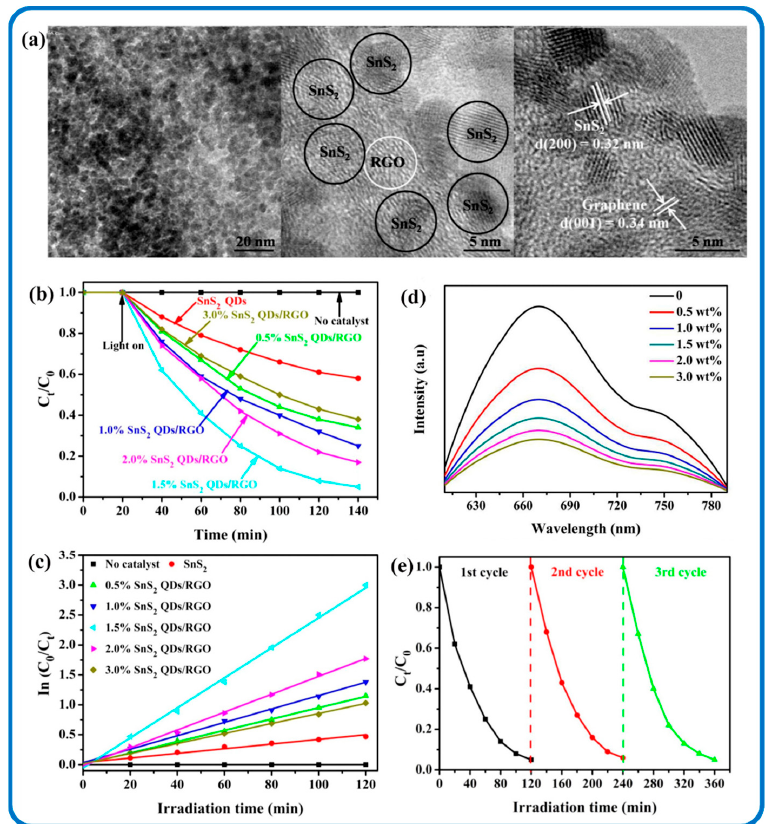
Figure 15. SnS 2 QDs/rGO nanocomposite photocatalyst ( a ) TEM and HRTEM images, ( b ) Cr (VI) reduction efficiency by photocatalysis, ( c ) kinetic linear simulation cures of Cr(VI) degradation, ( d ) UV– vis absorption spectra of SnS 2 loaded with different amounts of rGO, and ( e ) cycling runs of the photoreduction of Cr(VI) in the presence of SnS 2 QDs/rGO photocatalyst. Adapted with permission from [206]. Copyright 2016, Elsevier.